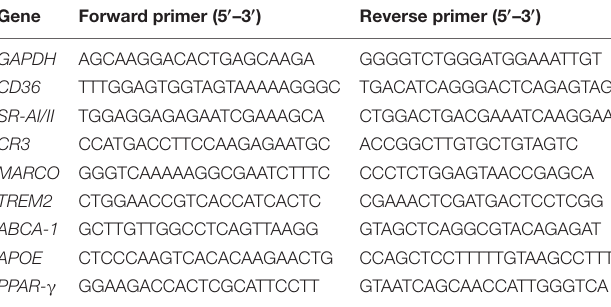
TABLE 1 | List of qPCR primers used to validate genes related to phagocytizing myelin debris. Gene Forward primer (5 (cid:48) –3 (cid:48) ) Reverse primer (5 (cid:48) –3 (cid:48)